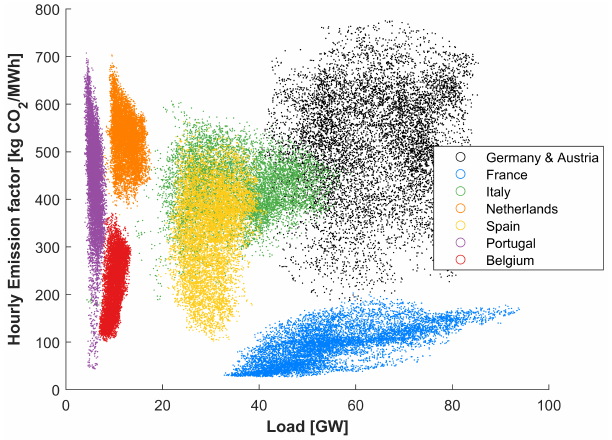
Figure 3. Country electricity load depicted against its HEF con .